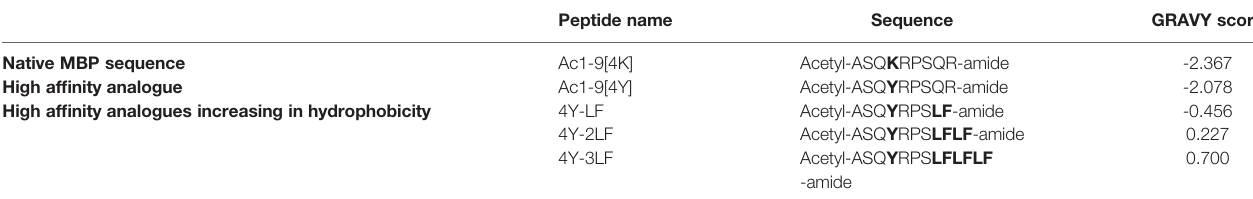
TABLE 1 | Properties and sequences of modi fi ed MBP